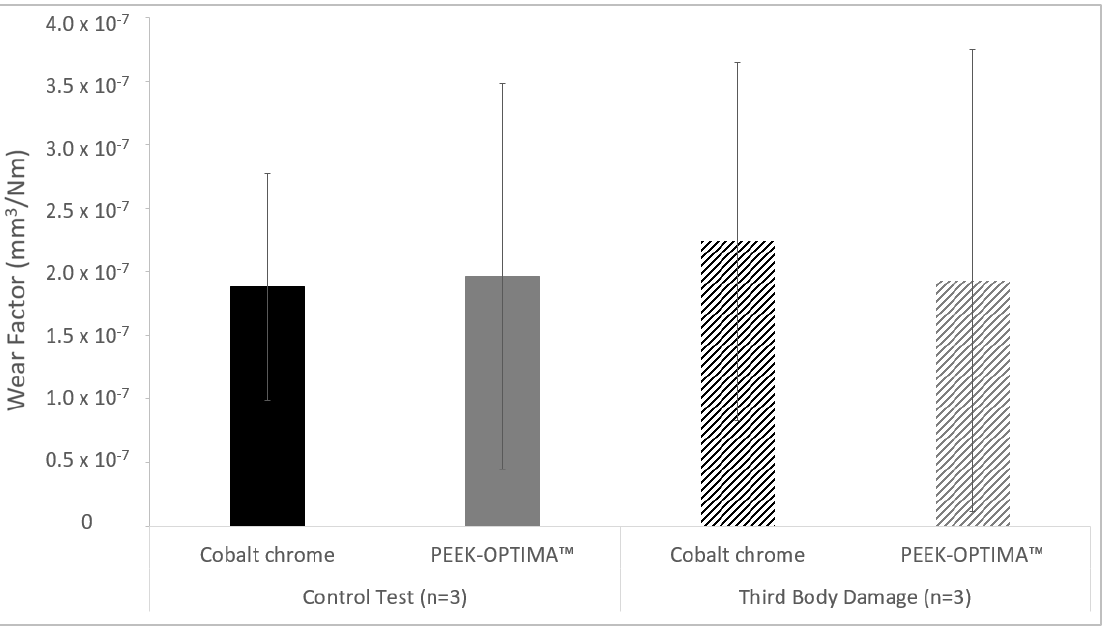
Figure 3. Mean wear factor (mm 3 / Nm) of UHMWPE pins ( ± 95% confidence limits) against smooth (control) CoCr and PEEK-OPTIMA ™ plates and plates which had undergone damage simulation with particles of PMMA cement (n = 3).